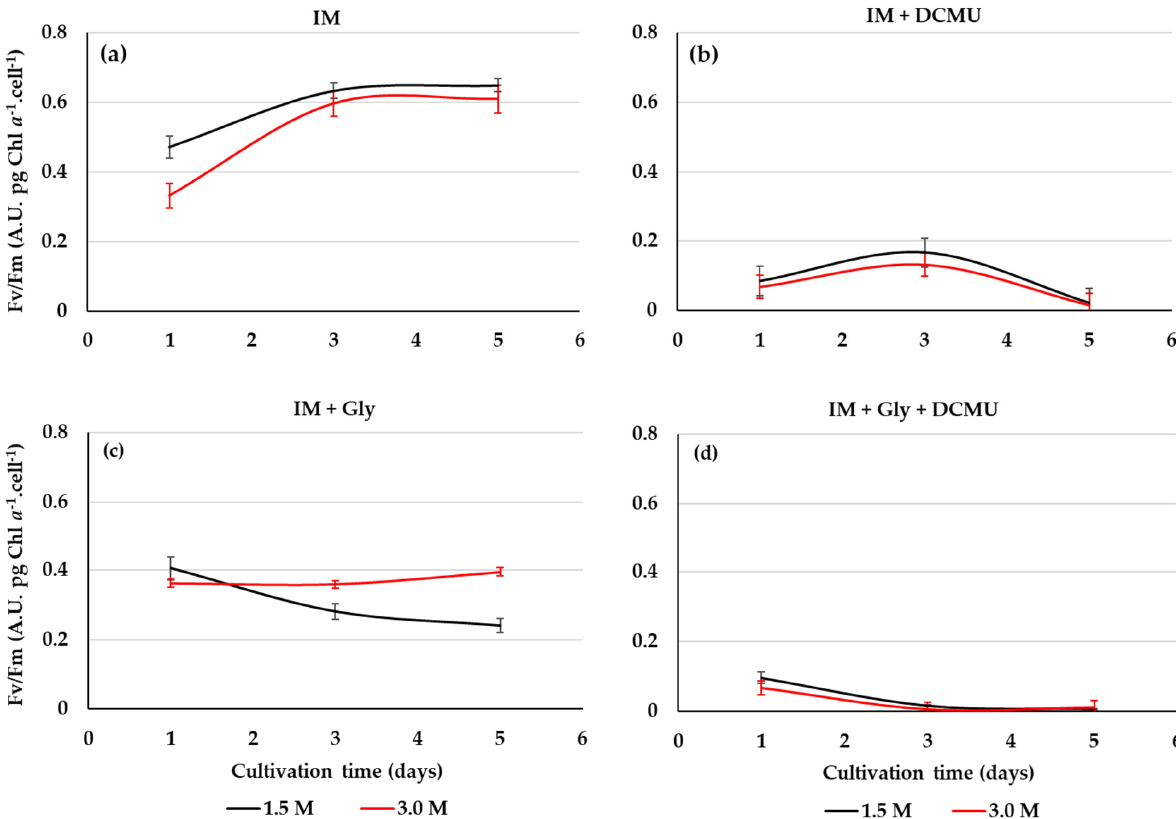
Figure 6. Photosynthetic efficiency (Fv/Fm) of D . salina cultivated at different conditions: IM ( a ), IM + DCMU ( b ), IM + 12.5 mM Gly ( c ), and IM + 12.5 mM Gly + DCMU ( d ). Culture salinities: 1.5 and 3.0 M NaCl. Values correspond to the mean ± standard deviation of three replicates.